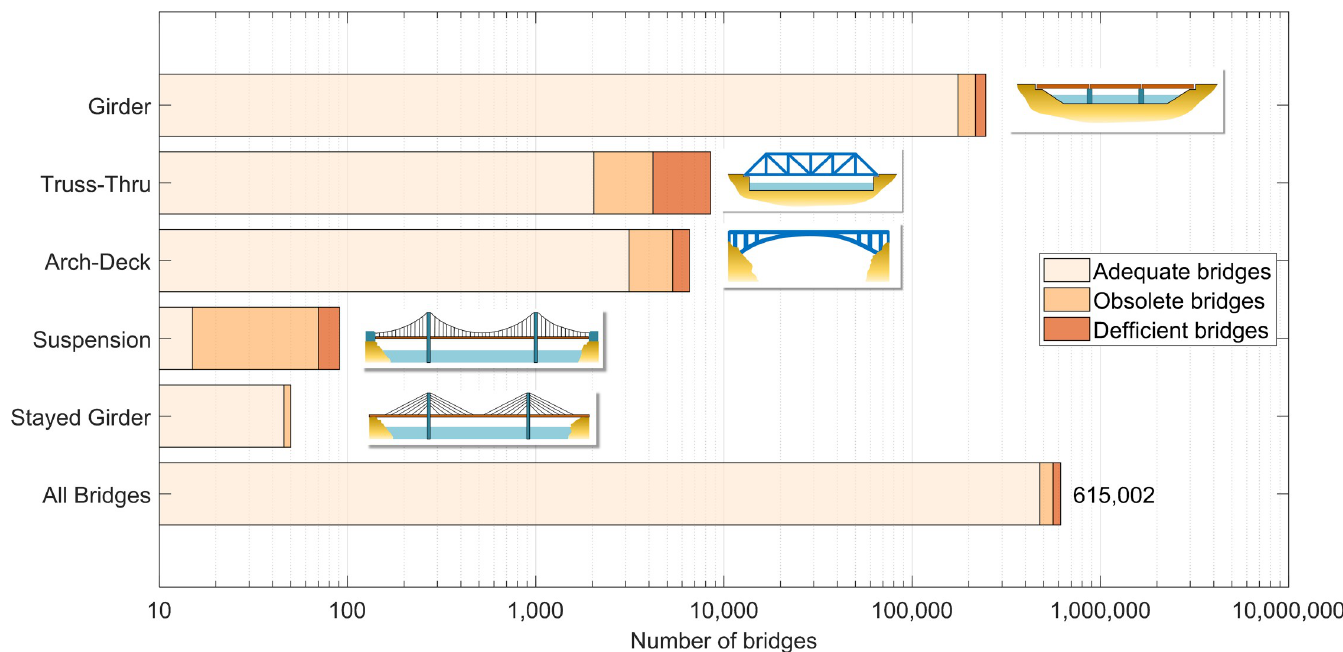
Fig 3. Distribution of bridges built in USA by type of design (number of bridges in